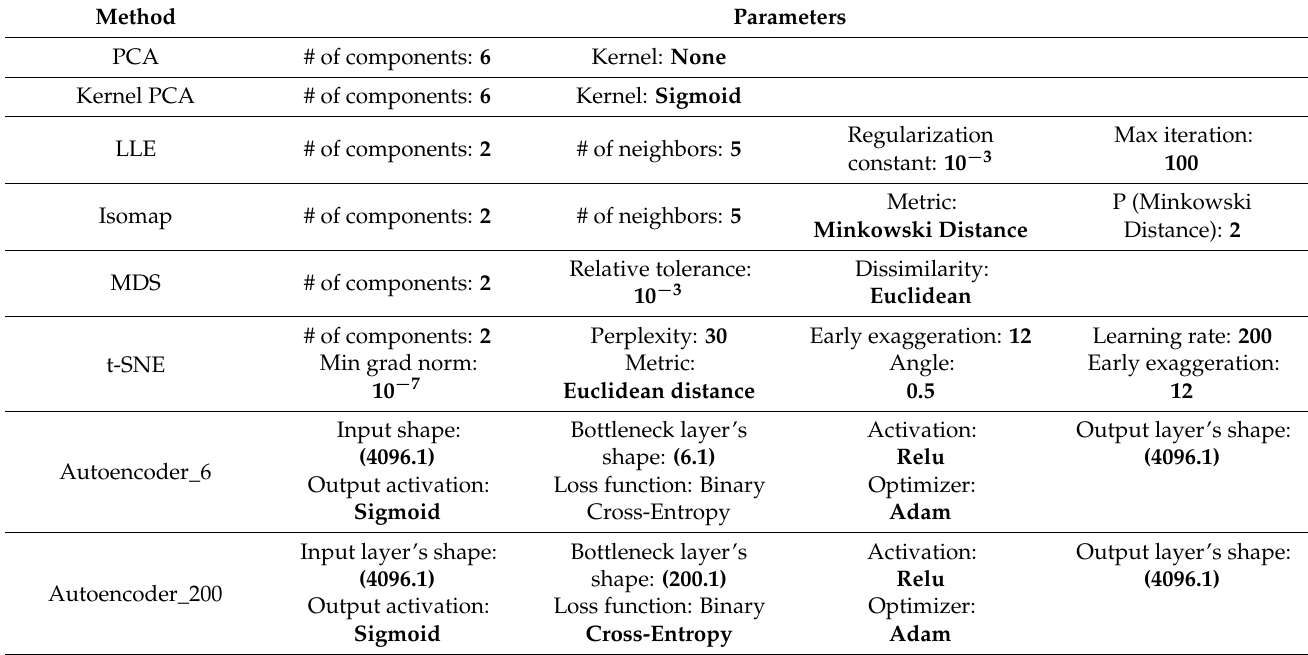
Table 2. Parameter values that are used with the encodings and